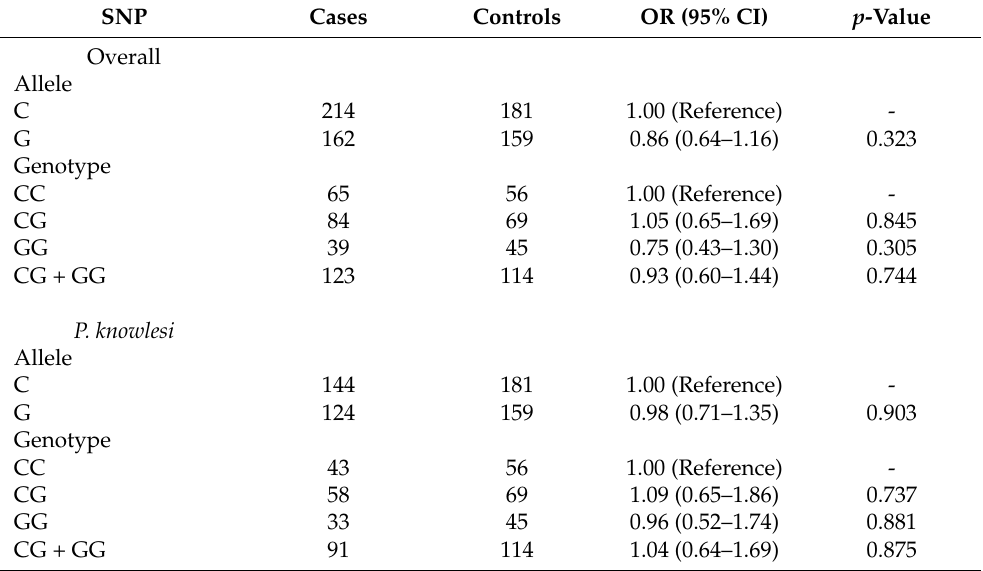
Table 4. Association of the β -like globin C16G SNP with malaria